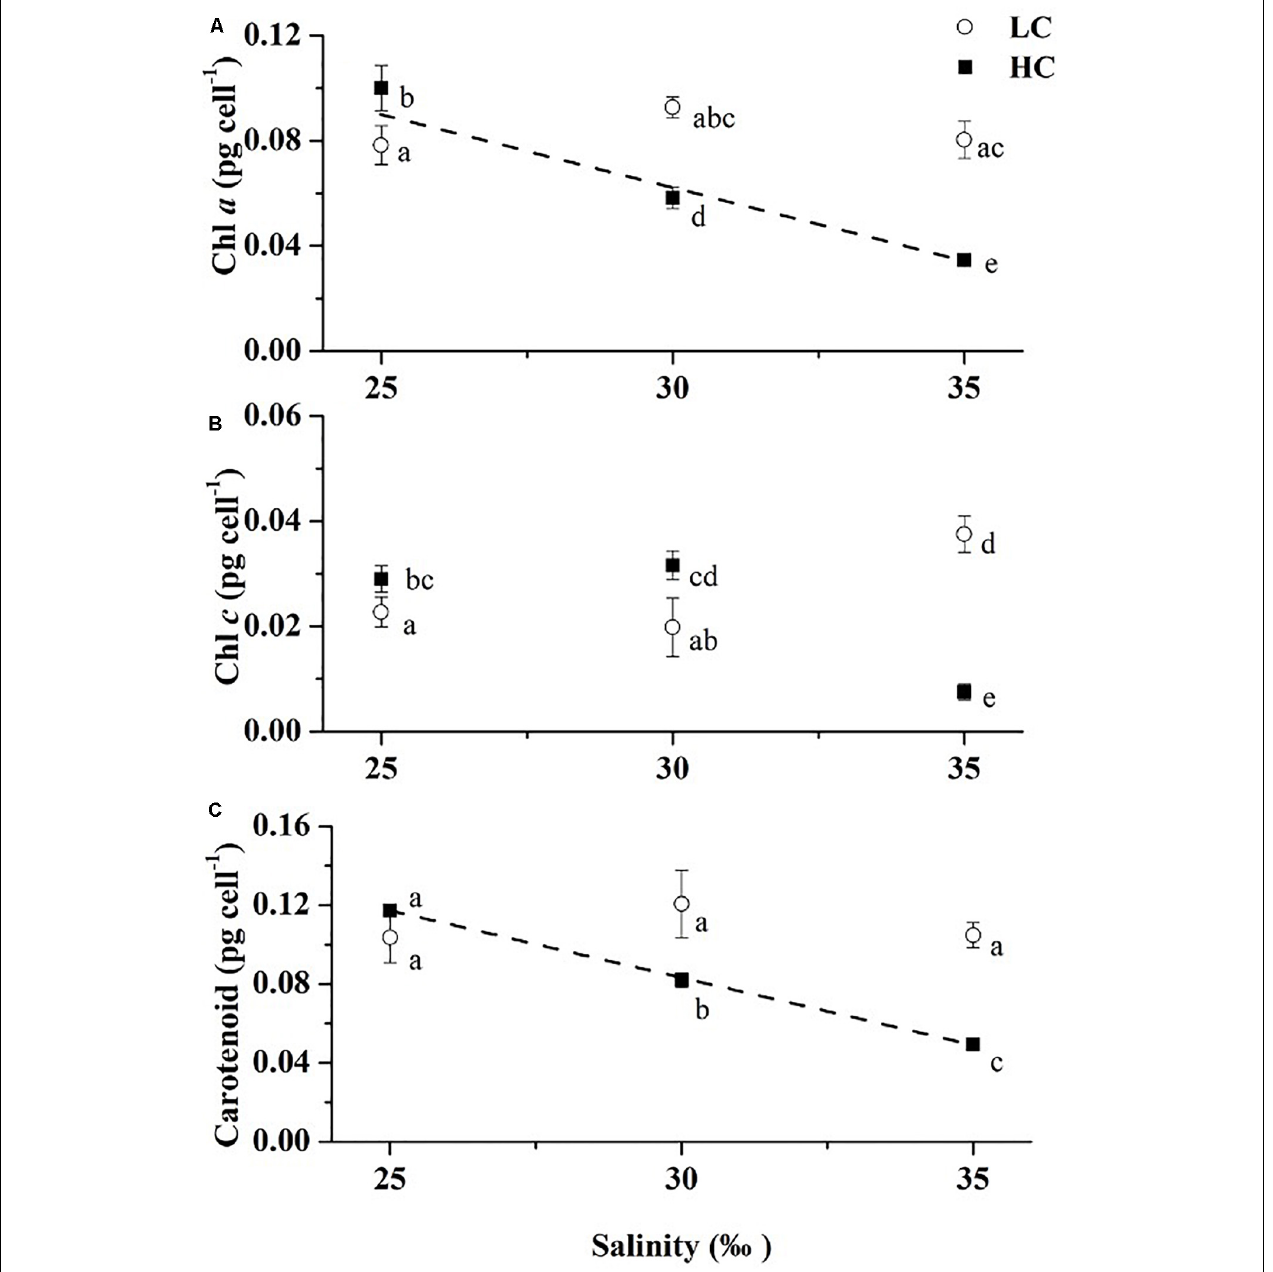
FIGURE 2 | Chl a (A) , Chl c (B) , and Carotenoids (C) contents of Emiliania huxleyi at three salinities (LC, open circles; HC, solid squares). Two dashed lines are the linear regression results of the chlorophyll a and carotenoids contents under HC, respectively ( y = -0.00562x + 0.23105, R 2 = 0.94; y = -0.00681x + 0.28755, R 2 = 0.99). Values are means ± SD of triplicate cultures. Symbols with different lowercase letters indicate significant differences ( p < 0.05) among different